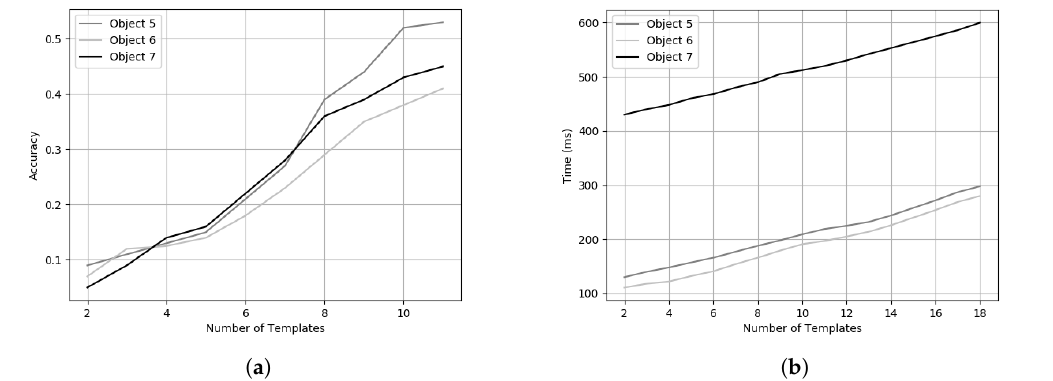
Figure 13. ( a ) Pose estimation accuracy vs. number of templates used for Objects 5, 6 and 7 in Scene 2. ( b ) Runtime vs. number of templates used for Objects 5, 6 and 7 in Scene